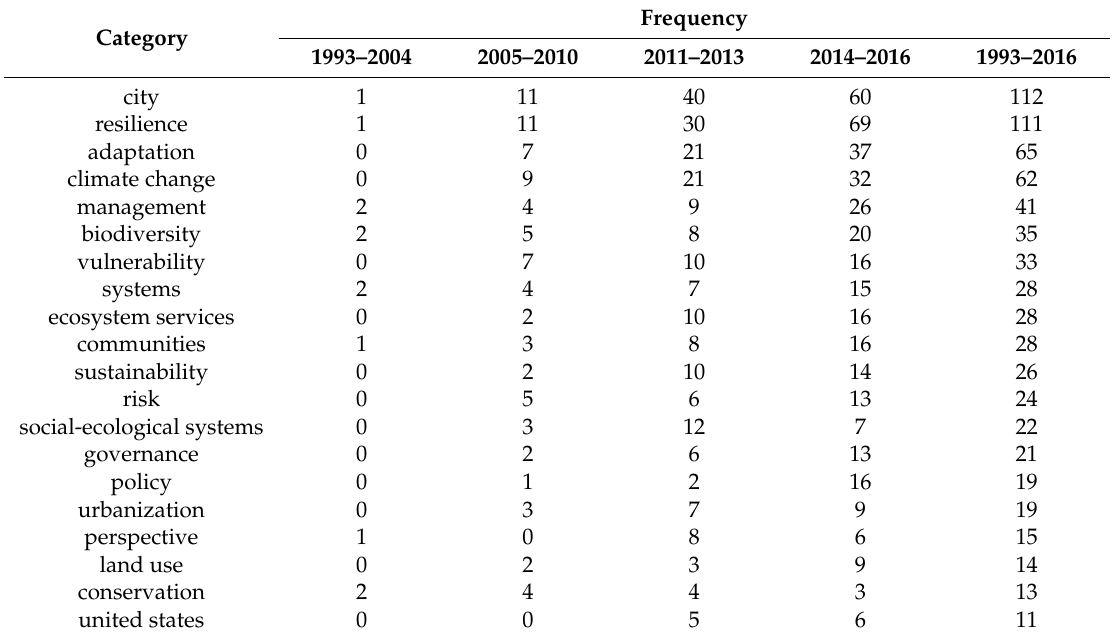
Table 3. The evolution trends of top 20 keywords on urban resilience